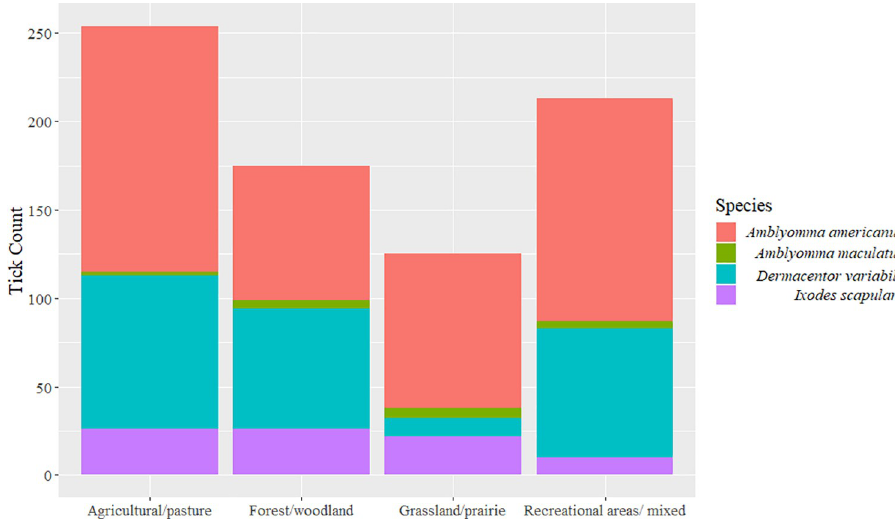
Fig 4. Ticks collected from the study region broken down by different landcover types.